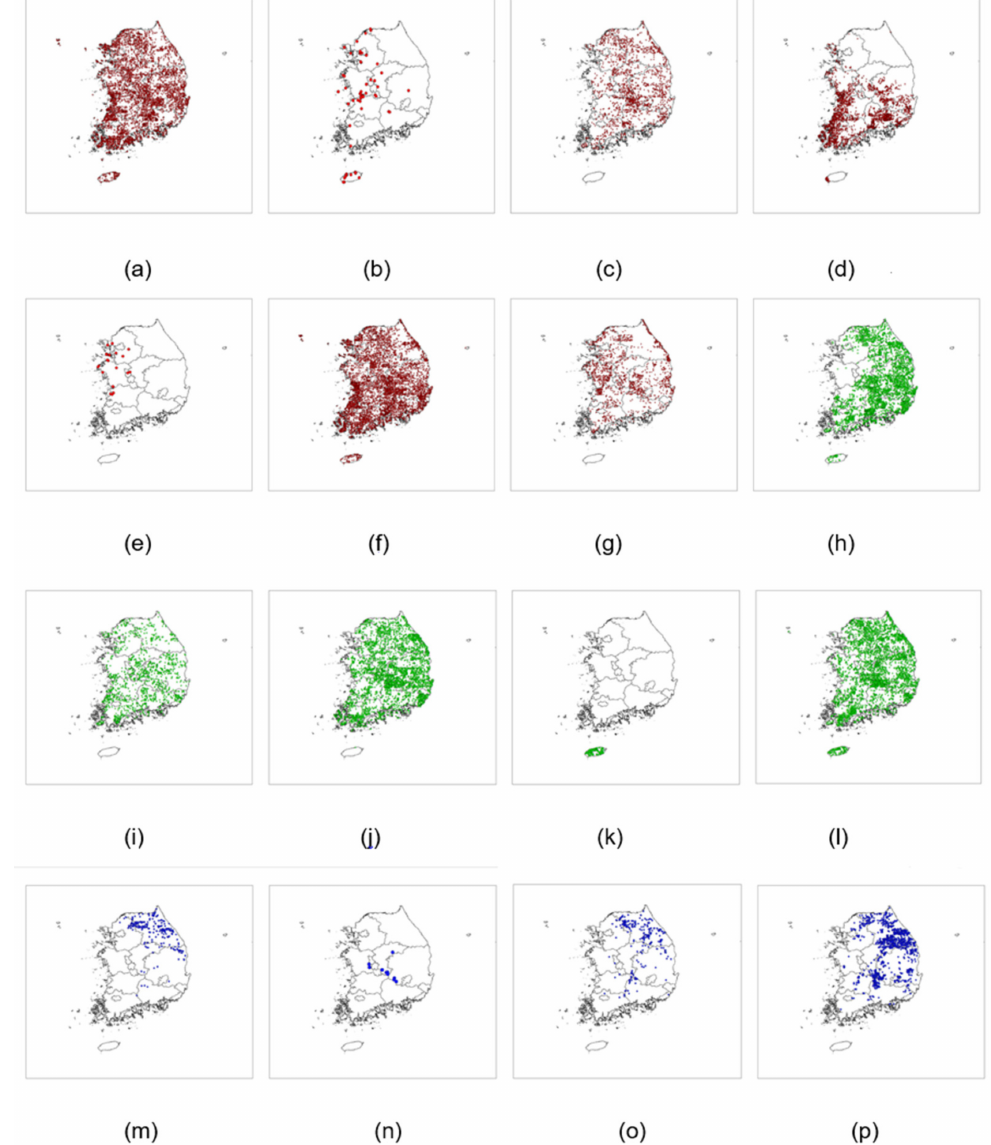
Figure 3. Occurrence points for 16 amphibian species: ( a ) H. japonica ; ( b ) K. borealis ; ( c ) G. rugosa ; ( d ) L. catesbeianus ; ( e ) P. chosenicus ; ( f ) P. nigromaculatus ; ( g ) R. coreana ; ( h ) B. orientalis ; ( i ) B. gargarizans ; ( j ) H. leechii ; ( k ) H. qualpartensis ; ( l ) R. dyboskii ; ( m ) B. stejnegeri ; ( n ) K. koreana ; ( o ) O. koreanus ; ( p ) R. huanrenensis